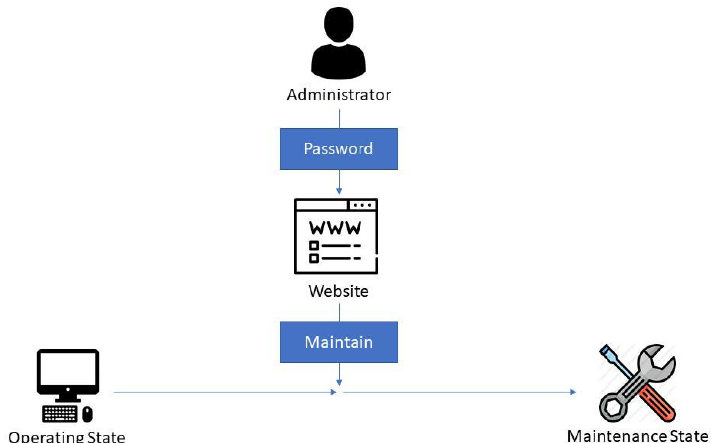
Figure 10. Maintain function: If the administrator wants to upgrade the programs or pause the monitor, the administrator inputs the password on the website and changes the system state into the maintenance state.